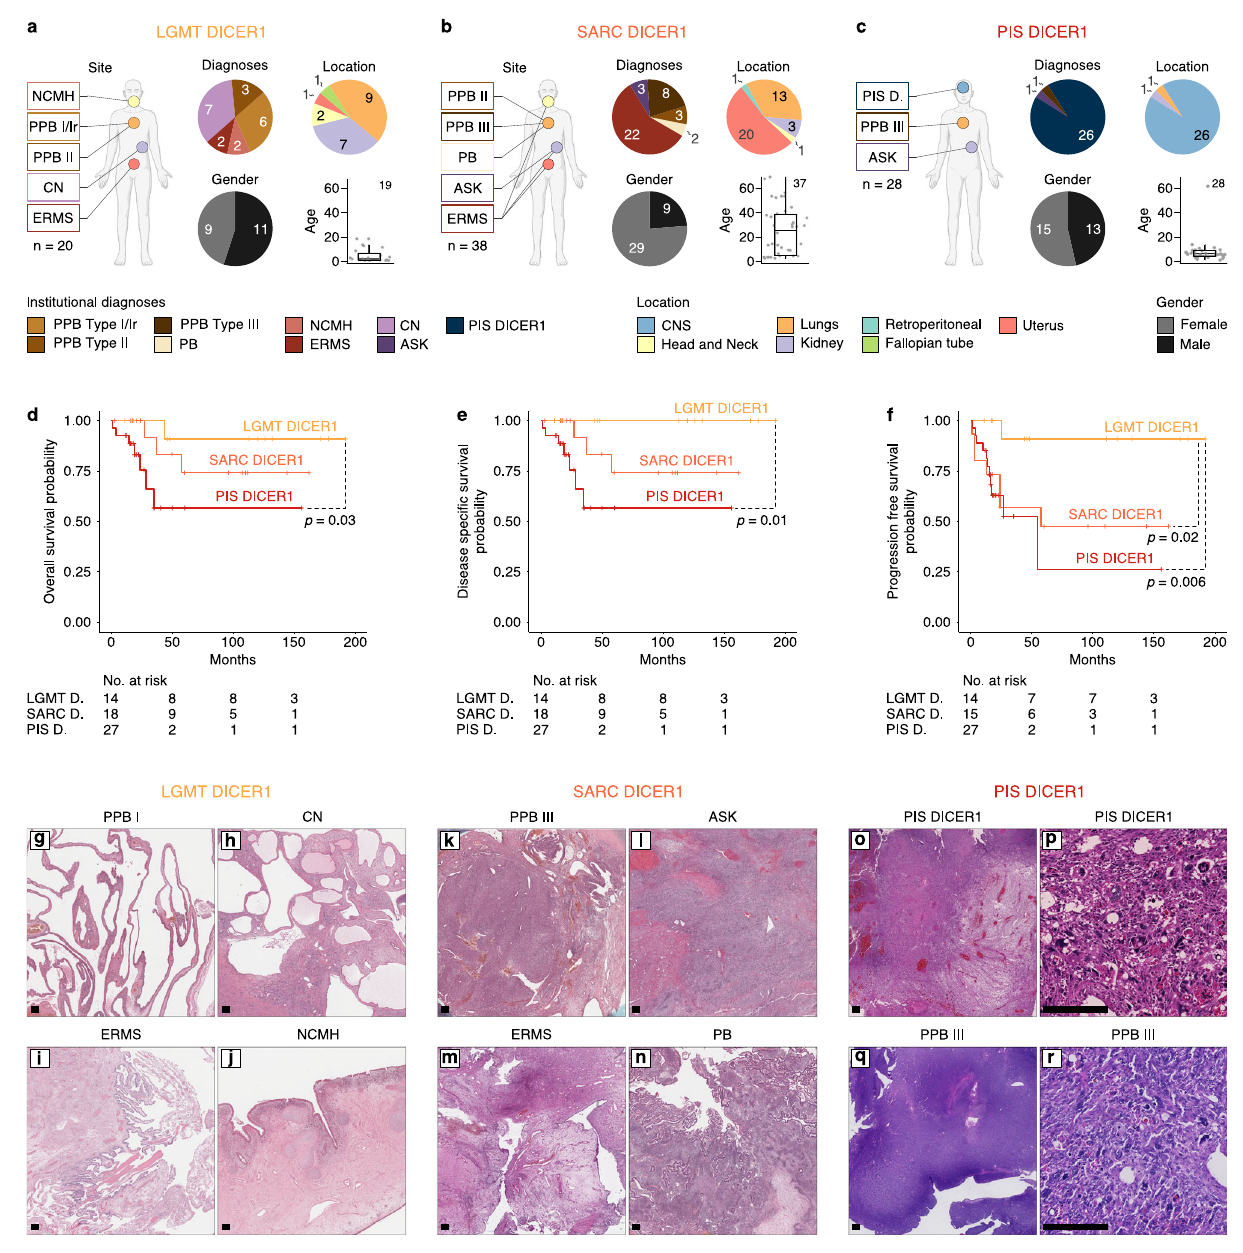
Fig. 2 | Clinicopathological features of mesenchymal neoplasms with DICER1 alteration. Institutionaldiagnoses,tumorlocation,genderdistributionandpatient ageof a LGMTDICER1, b SARCDICER1and c PISDICER1(relatedtoSupplementary Fig. 3). Black lines mark the median, edges of boxes denote interquartile range (IQR), and vertical lines indicate 1.5 × IQR. The number of independent samples is indicated. Kaplan – Meier survival curves (Kaplan – Meier estimates) indicating ( d ) overall survival, ( e ) disease speci fi c survival and ( e ) progression free survival for LGMT DICER1, SARC DICER1 and PIS DICER1. Signi fi cant differences are indicated